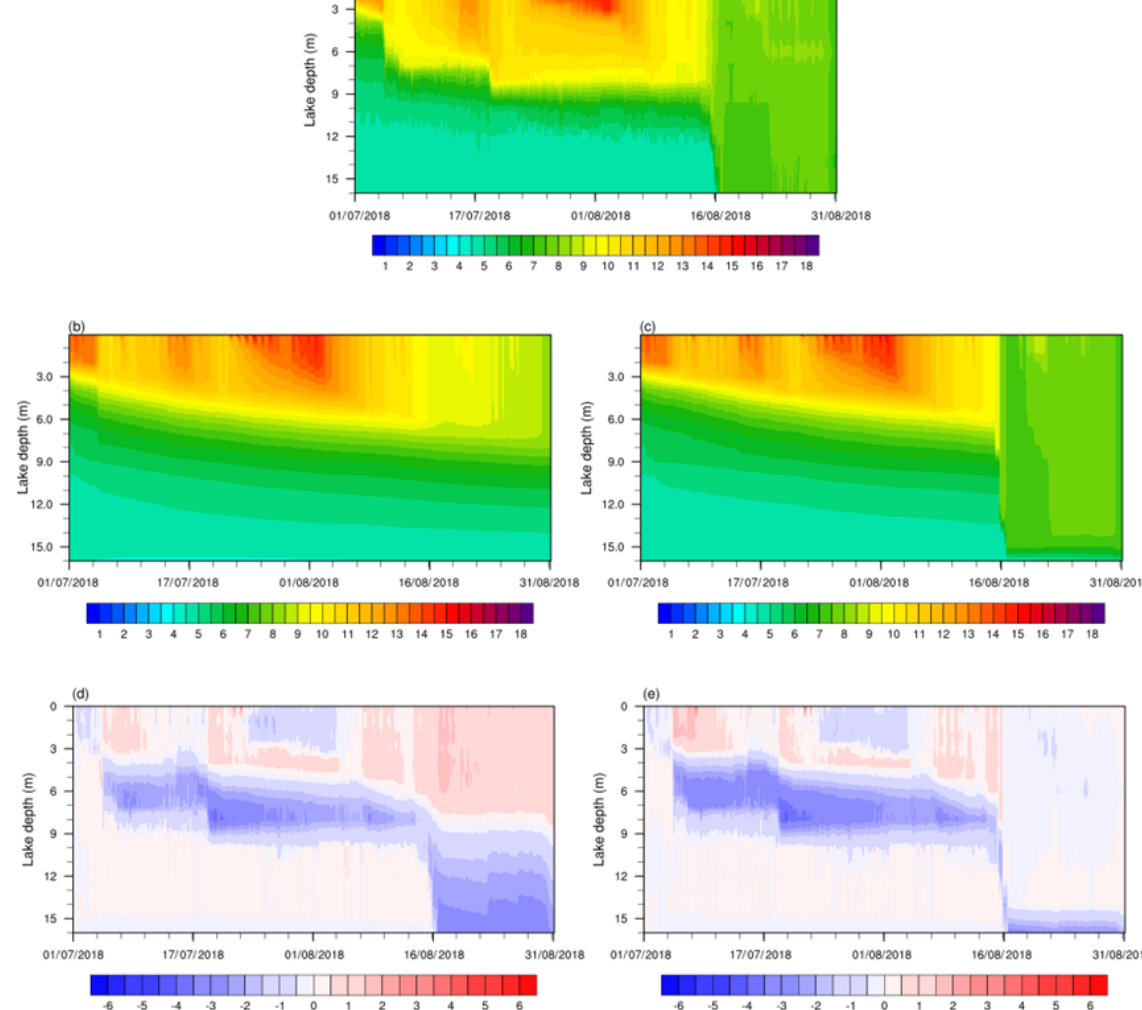
Figure 3. Lake temperature profiles of (a) observations and simulations with (b) CLM-ORG and (c) CLM-KPP. Lake temperature profile differences between simulations and observations: (d) CLM-ORG minus observations and (e) CLM-KPP minus observations (unit: ◦ C).